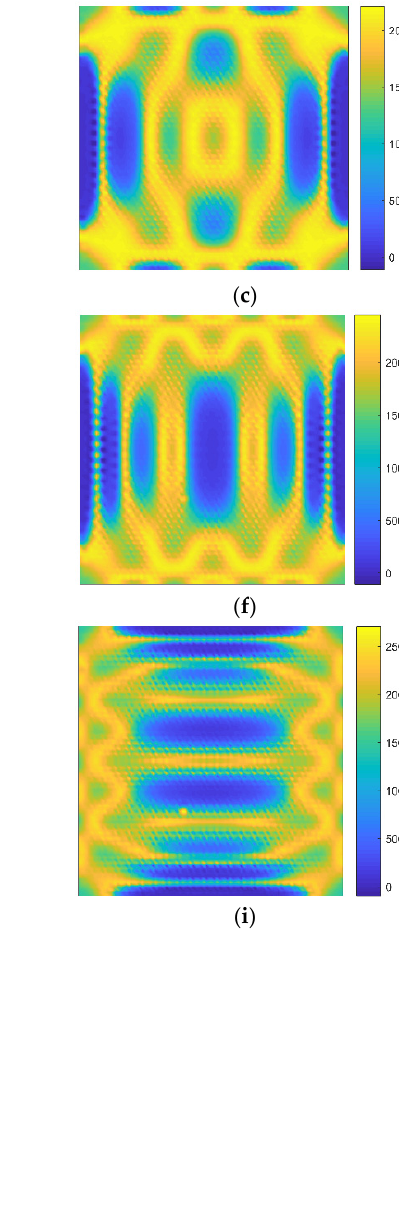
Figure 5. The number distributions of indistinguishable atoms with the identification limitation at 10 − 4 Thz (( a – j ) represent the distributions from the 1st to the 10th resonant vibration modes,